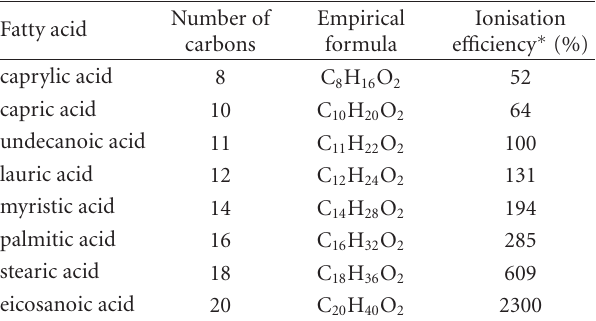
Table 3: Electrospray ionization e ffi ciency of di ff erent fatty acid compared to undecanoic acid ( pK s = 4,69 for all